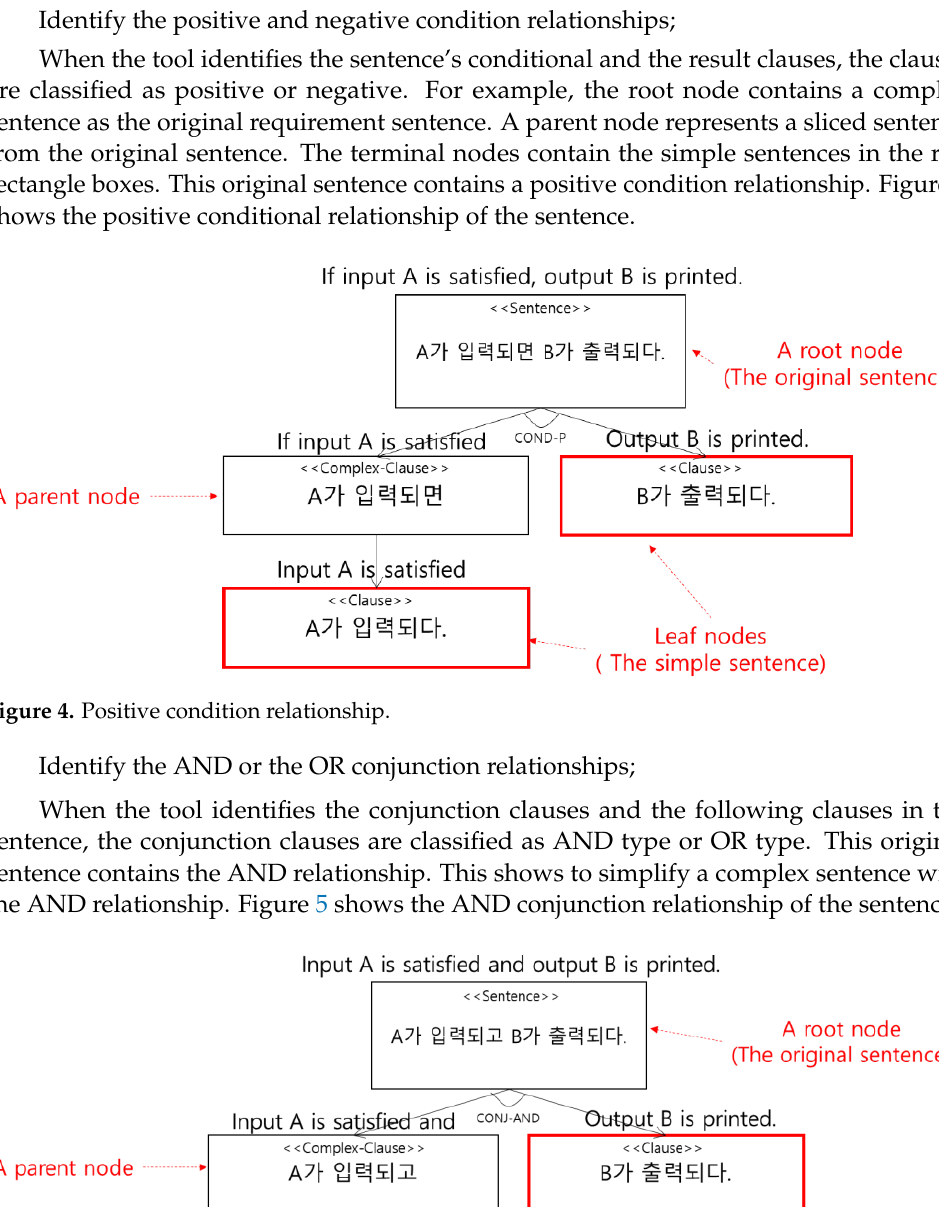
Figure 6. Corpus normalization.